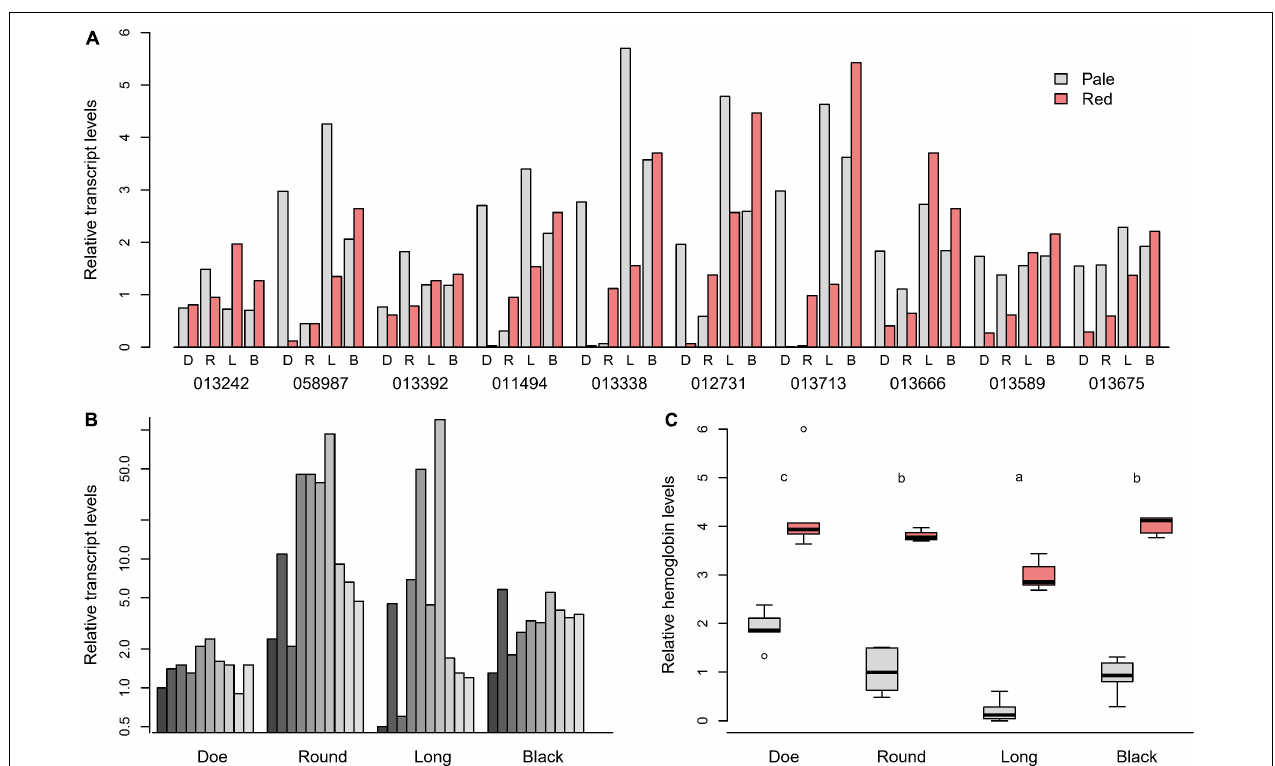
FIGURE 5 | (A) Transcript levels in D. pulicaria for the 10 most abundant hemoglobin transcripts (reported as Daplx7pEVm0#####), expressed relative to the mean of the pale animals. (B) Induction of Hb mRNA seen in red animals relative to the pale from the same lake for each gene in (A) . (C) Relative Hb protein levels, scaled to the mean of the pales. Different letters in (C) indicate significant differences ( p < 0.05).